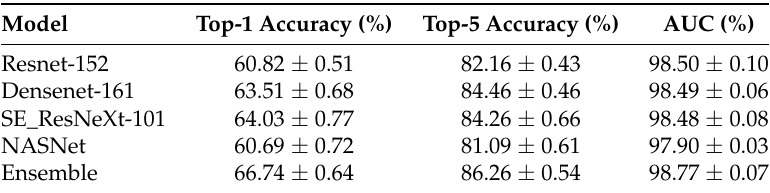
Table A2. Detailed results of 622-ary classification for individual classifiers and their ensemble on